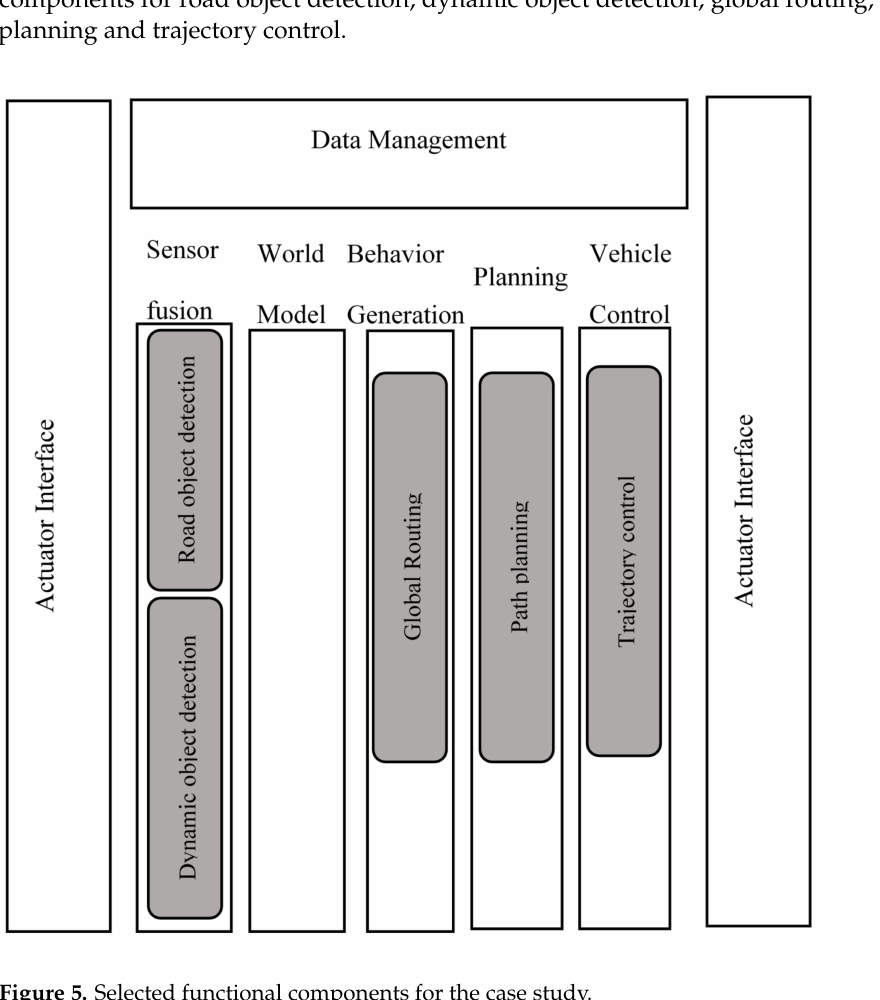
Figure 5. Selected functional components for the case